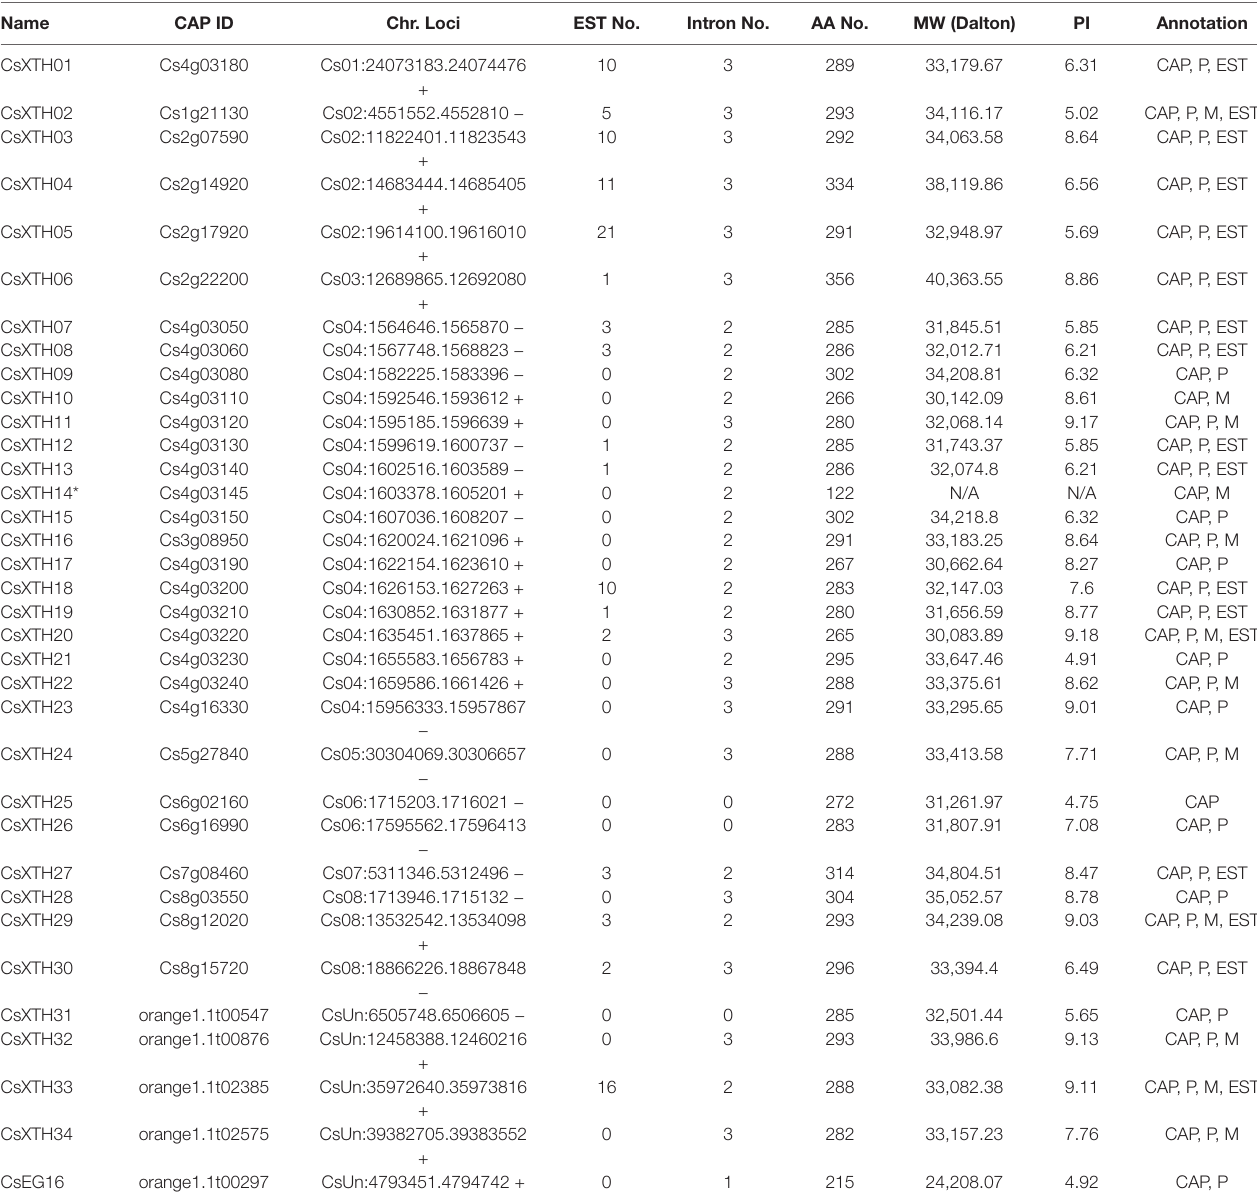
TABLE 1 | Summary of XTHs and EG16 identified in the genome of sweet orange. All XTHs and EG16s are